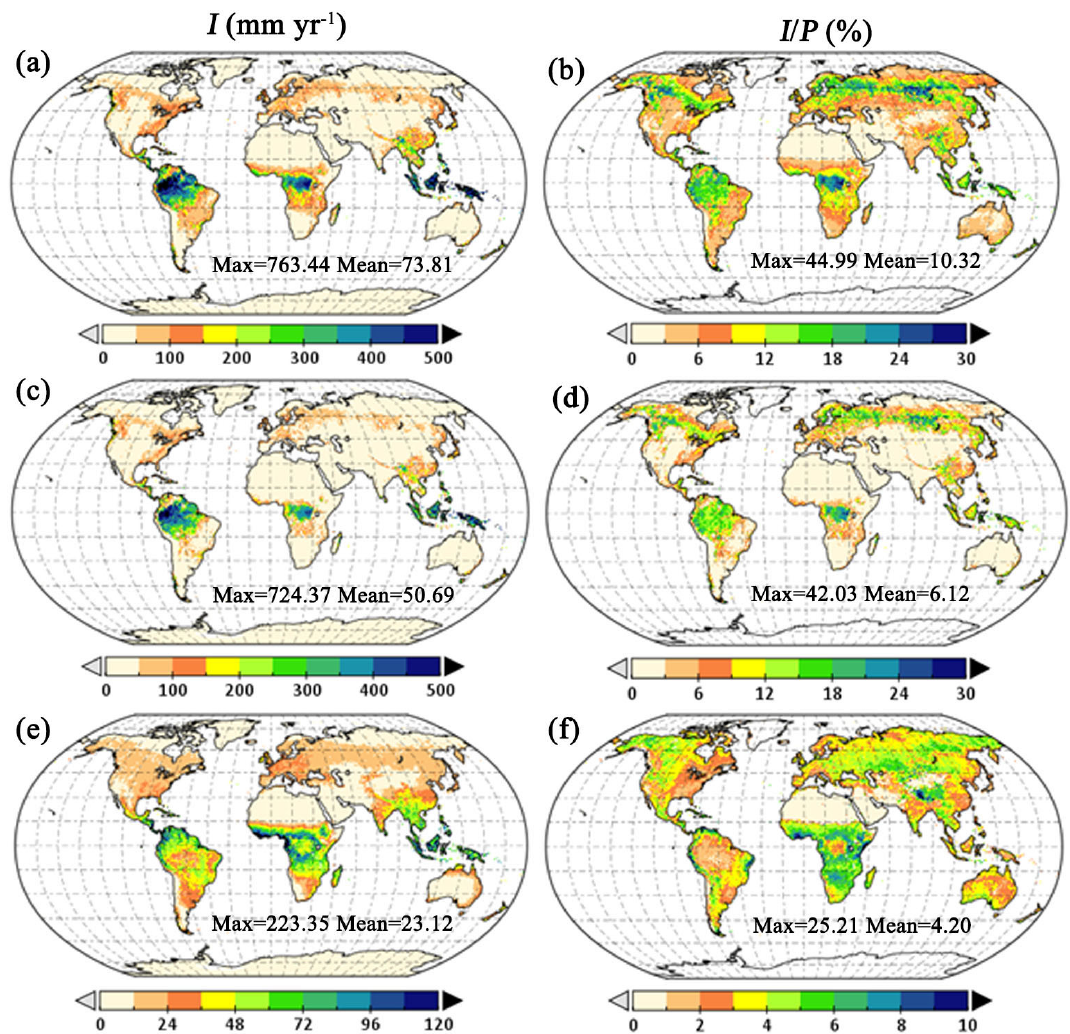
Figure 4. Global distribution of annual rainfall interception loss. Average I (in mmyr − 1 ) (a) and the contributions from tall (c) and short (e) vegetation. Average I/P (%) (b) and the contributions from tall (d) and short (f)